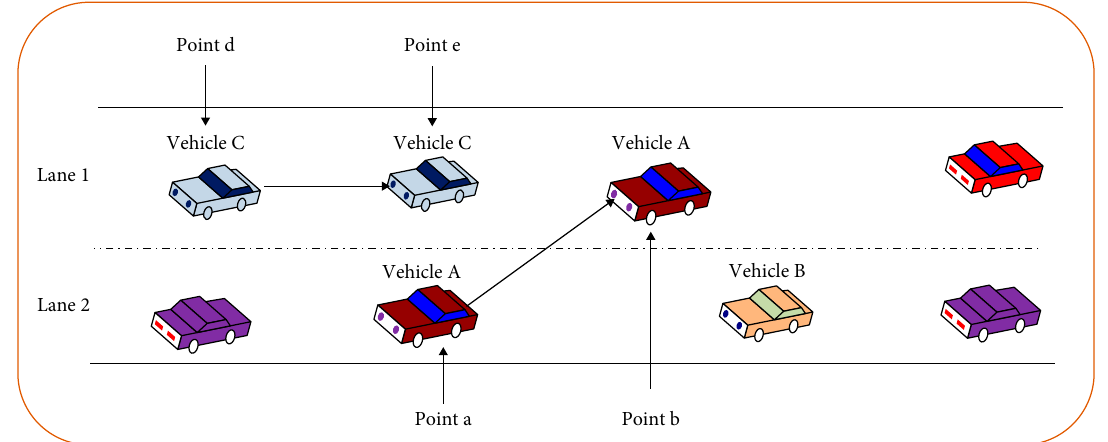
Figure 5: Traffic incident detection based on lane changing speed.